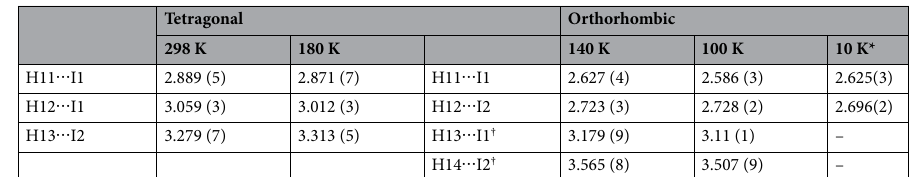
Table 2. Main H-bond distances of MA at different temperatures. *Values correspond to a deuterated sample reported by Whitfield et al . 41 . † These distances correspond to the 180° rotated MA.